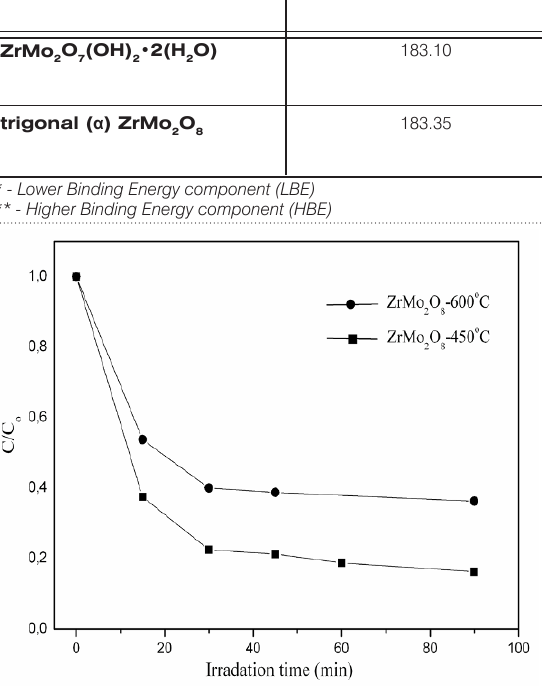
Table 1. The value of the binding energies of Zr3d, Mo3d and O1s in the samples (in eV) (the value in parentheses indicate the relative amount of different components) Samples